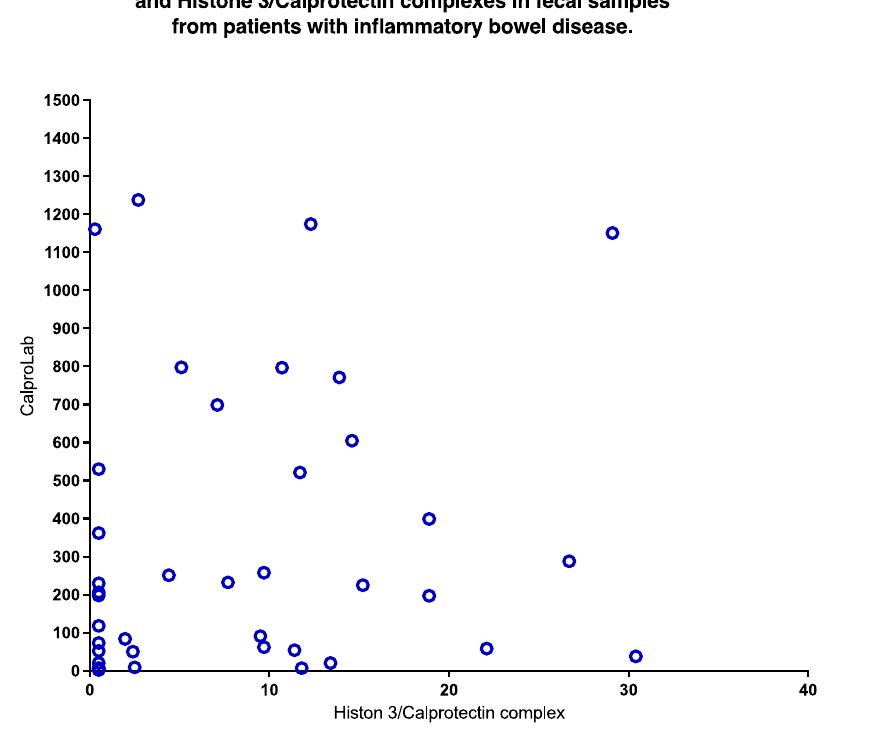
Figure 9. A plot of concentrations of CP and NETs in stools from IBD patients shows a non-signifi- cant correlation. High values of CP occurred despite low levels of NETs and vice versa.